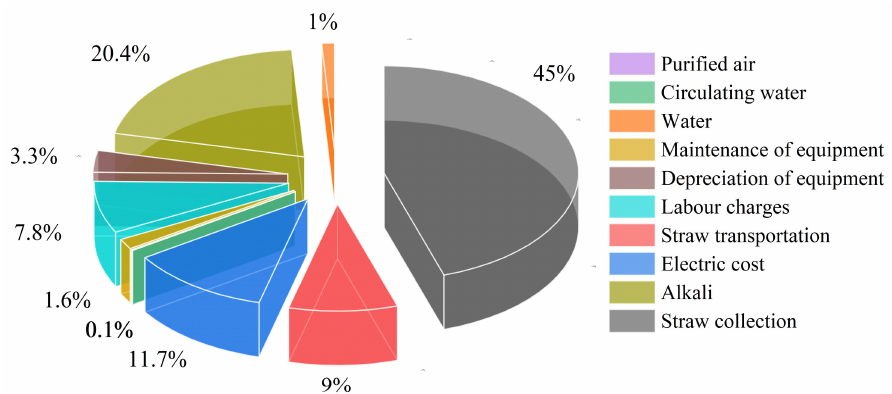
Figure 6. Economic cost distribution of the non-phase-transition drying pyrolysis and mass conver- sion